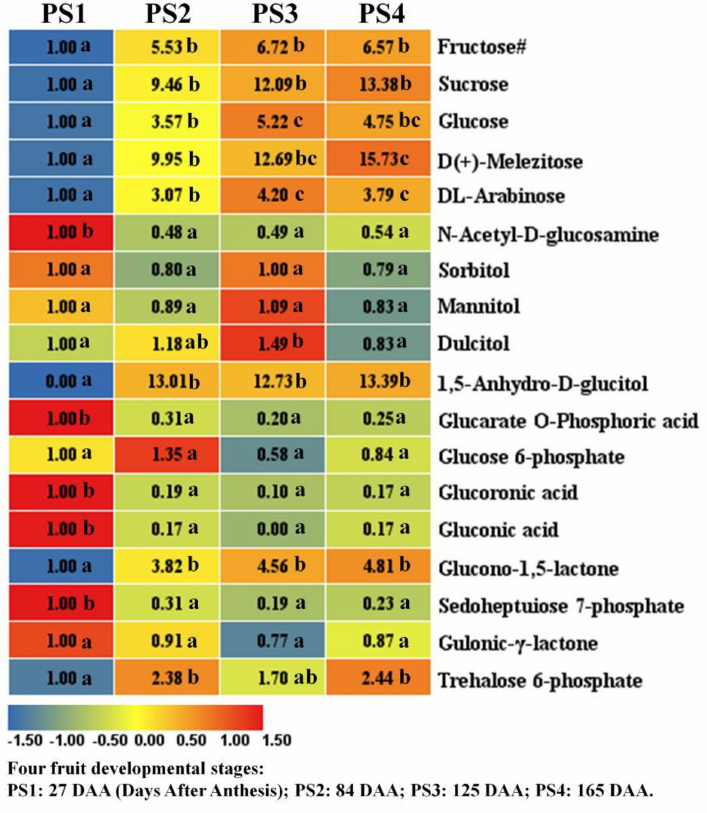
Figure 2. Sugar metabolites detected by widely-targeted UPLC-MC during four fruit developmental stages. Four ‘Pinova’ fruit development stages were analyzed: 27 (PS1), 84 (PS2), 125 (PS3) and 165 (PS4) Days After Anthesis (DAA), respectively. The fold changes of each metabolite among these four stages were displayed in heat map which used the first stage of 27 DAA as the calibrator. The Fructose# means that we additionally applied GC-MS to detect fructose content, because we failed to identify fructose by widely-targeted LC-MS metabolomics approach in this study. Three independent replicates were performed for each stage. Significant analysis was performed by SPSS software based on Tukey’s test at p < 0.05 level and showed with lower cases a, b, and c in figure. Di ff erent letters indicate significant di ff erences between two